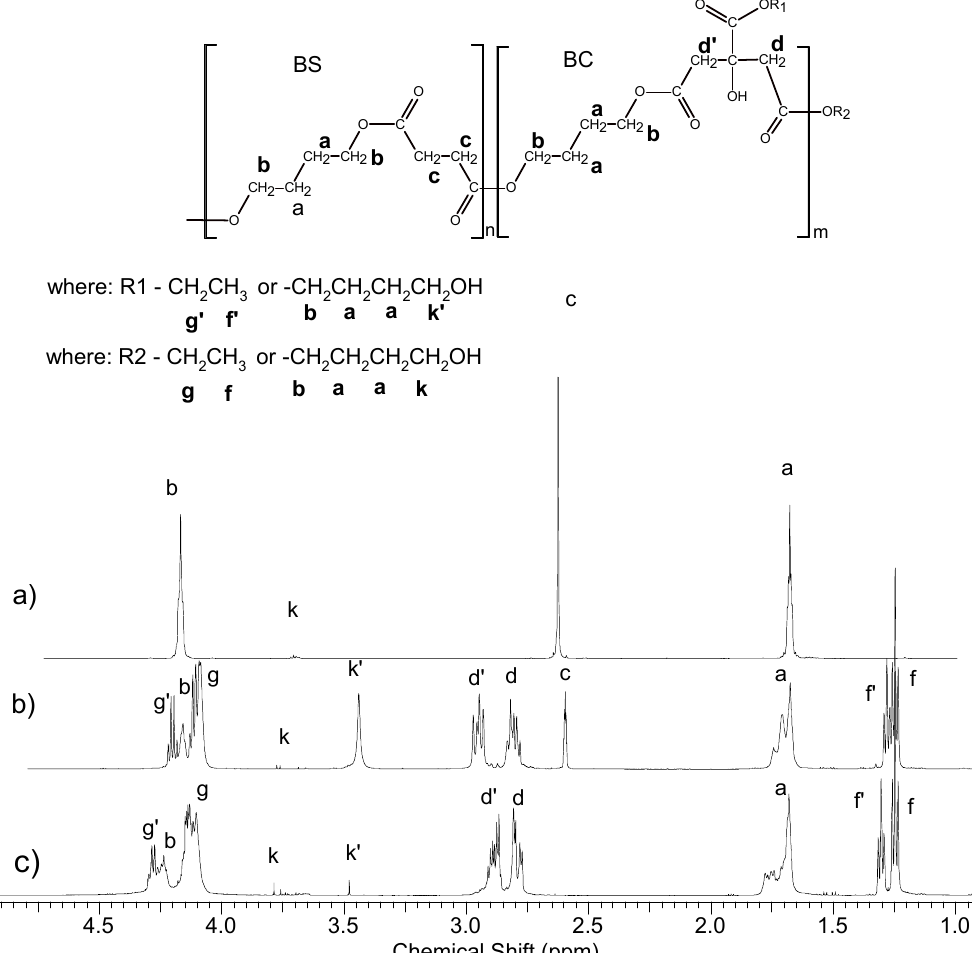
Figure 2. 1 H NMR spectra of polyesters ( a ) NG6 poly(butylene succinate); ( b ) NG 23 poly(butylene succinate- co -butylene citrate) and ( c ) NG48 poly(butylene citrate).